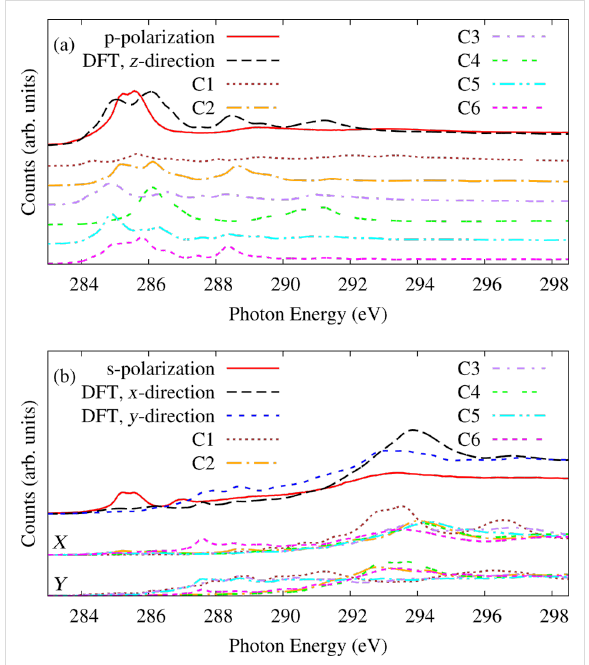
Figure 7: (a) Analysis of the initial state effects in the simulated NEXAFS spectrum and its comparison with the experimental one measured in p-polarization (electric field along z , i.e., perpendicular to the surface). (b) Same as (a), in s-polarization. Simulations are shown for electric field in the x - and y -directions, i.e., along the long and short molecular